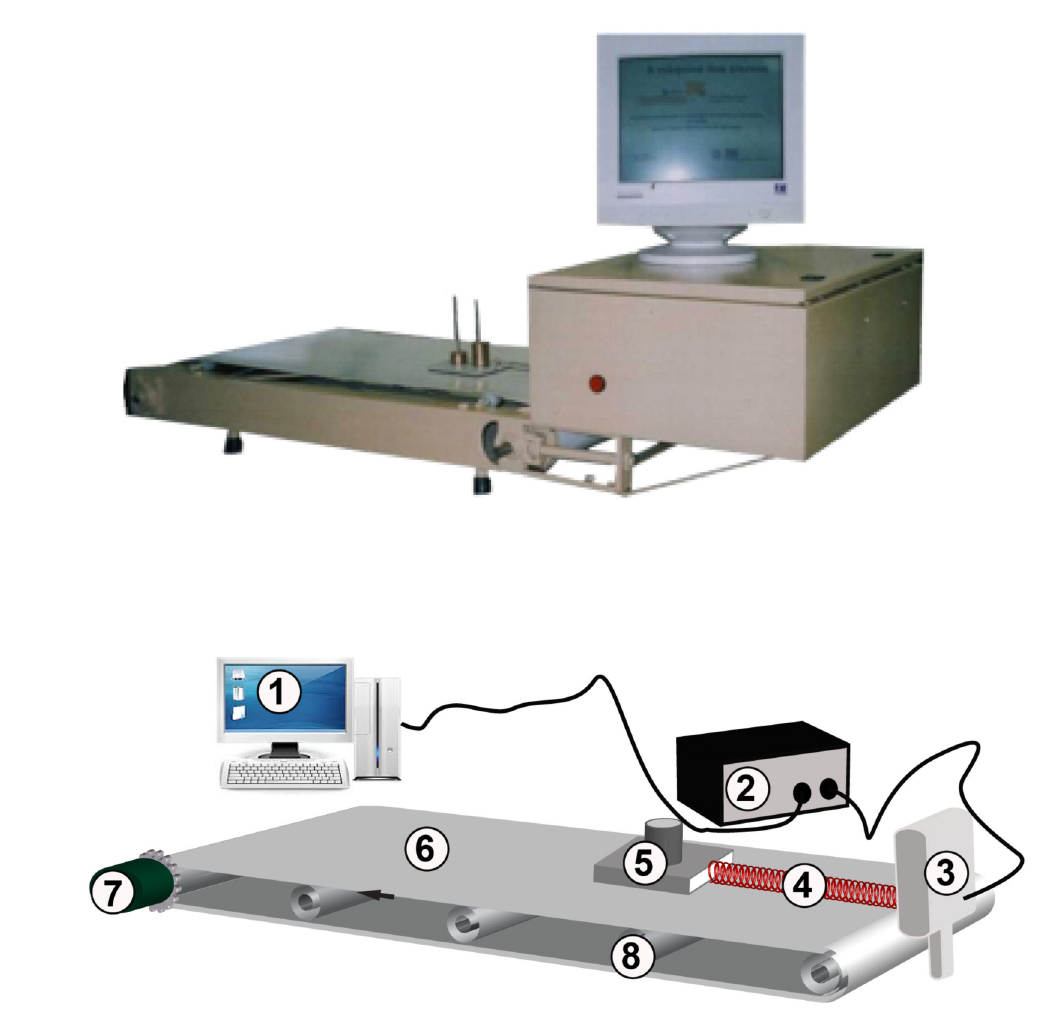
Figure 2. Top: Photograph of the earthquake machine prototype. The left part contains the mechanical components, including the carpet and the block that is connected to the spring. The right side of the apparatus contains the control box, which consists of a computer acquisition system, a force sensor, and a motor control. Bottom: Schematic representation of the earthquake machine prototype: (1) personal computer; (2) electronic interface; (3) force- sensing; (4) spring; (5) block; (6) rotating carpet; (7) motor; (8) rotating